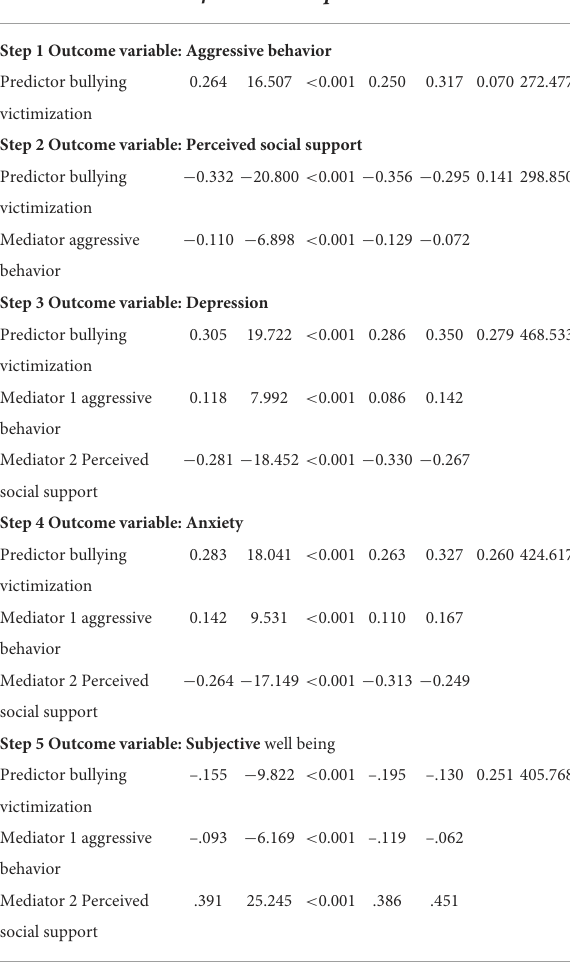
TABLE 3 Regression model of the effect of bullying victimization on mental health among Chinese teenagers. Variables